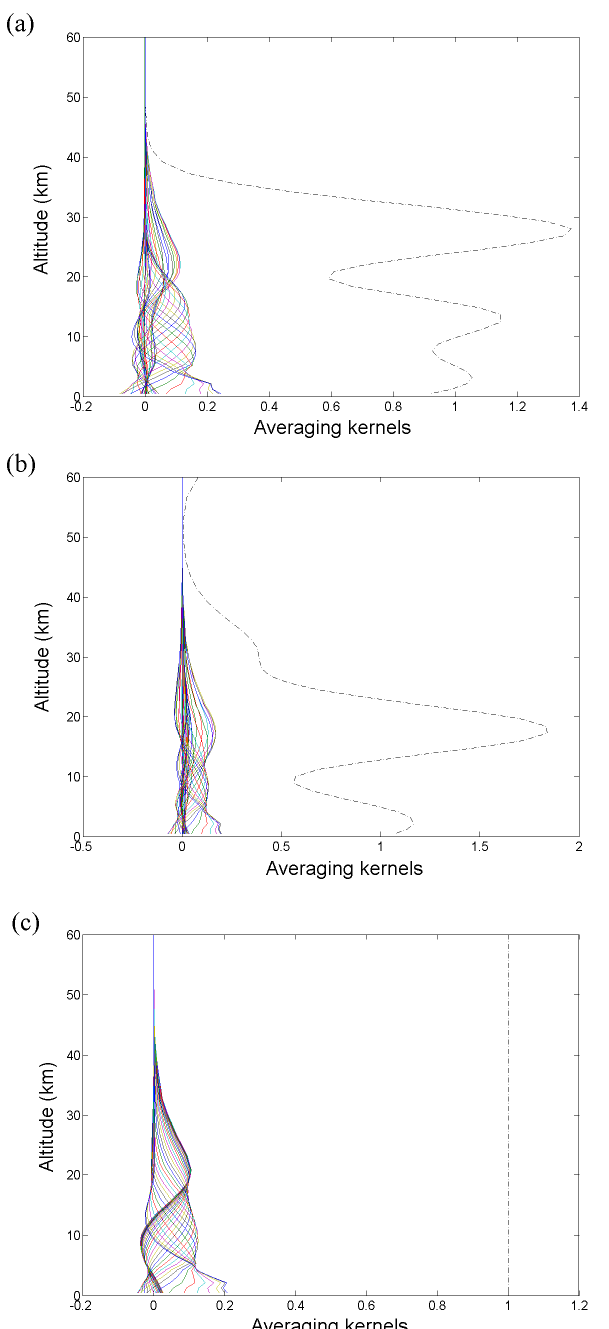
Fig. 6. Averaging kernels and sensitivity curve (black dashed) for the N 2 O retrieval from a single spectrum on 8 October 2007 at St.- Denis using the (a) OEM, (b) IOA and (c) TR.